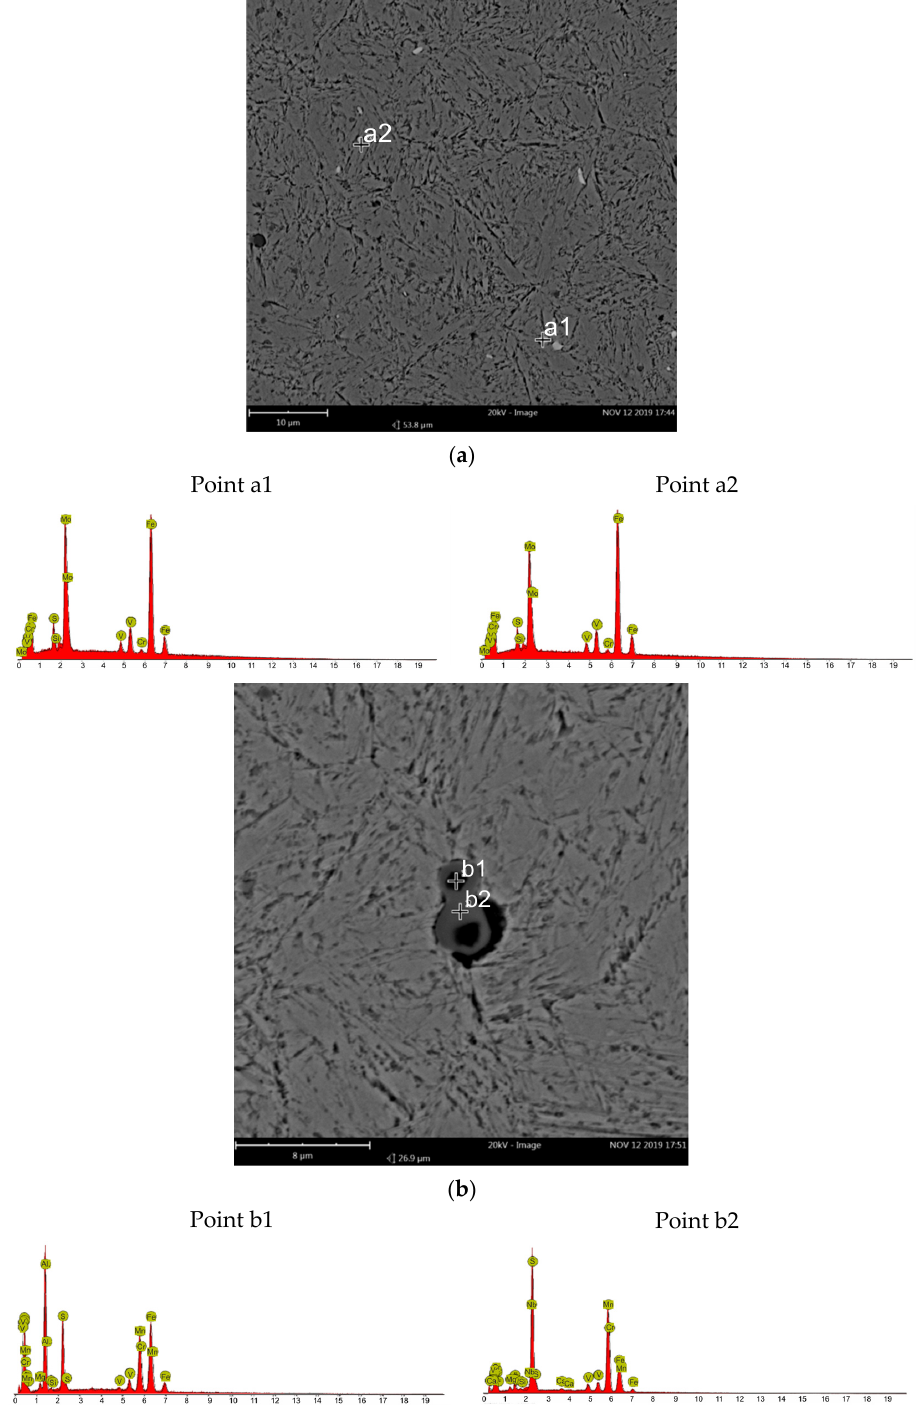
Figure 6. Microstructure of die insert alloy matrix material with results of microanalysis of the che-mical composition (EDS) of microstructure components (SEM) at two different areas of the die insert ( a , b ).